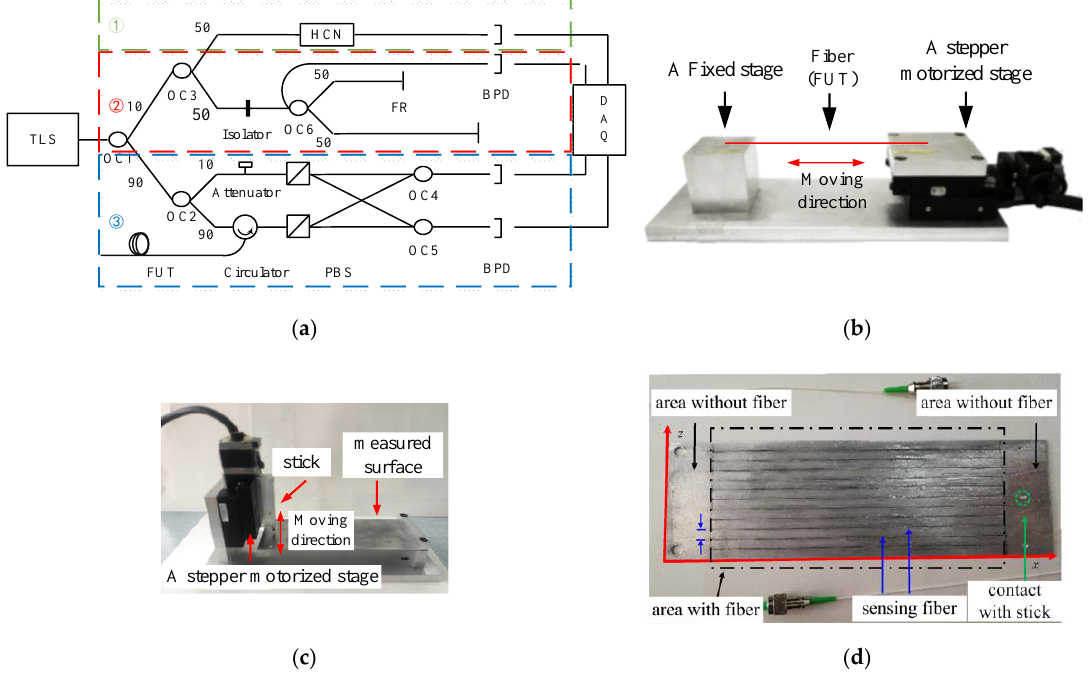
Figure 5. Schematic of the experimental systems: ( a ) configuration of the OFDR distributed sensing system, wherein OC is optical coupler, FR is Faraday mirror, BPD is balanced photodetector, PBS is polarization beam splitter, HCN is hydrogen cyanide gas cell, and DAQ is data acquisition card; ( b ) experimental setups of stretching fiber device for generating distributed strain; ( c ) experimental setups of surface strain testing device; and, ( d ) the fiber glued on the Aluminum alloy plain.